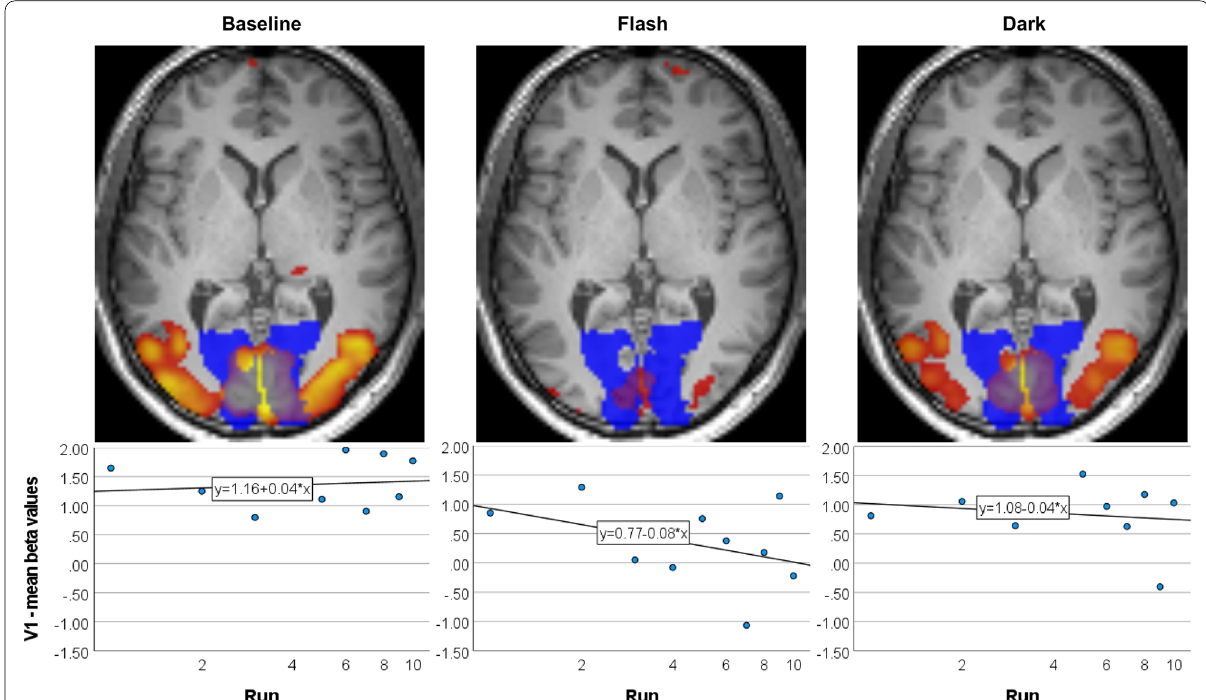
Fig. 1 Individual habituation curves in the primary visual cortex (V1), illustrated for patient P07. Visual activation was induced by a flickering light task (10 runs, block design, FWE-corr. 0.05, activation displayed in red to yellow). Mean beta values within the V1 region of interest (blue) were extracted for each run and linearized using the natural log transform, resulting in uncorrected individual habituation curves per